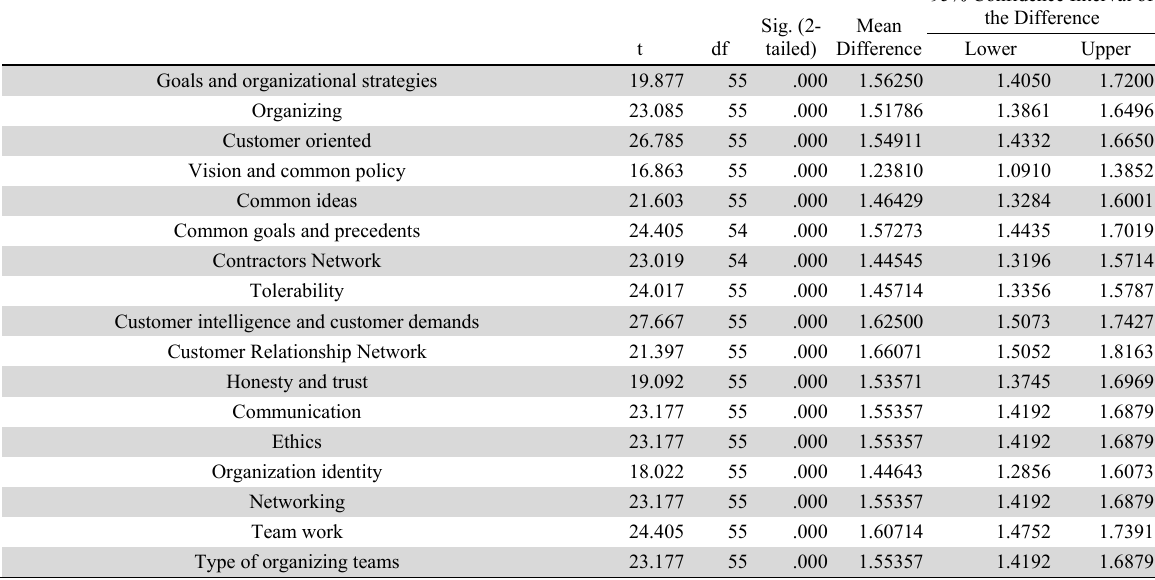
The results of the implementation of lessons’ learned on new product